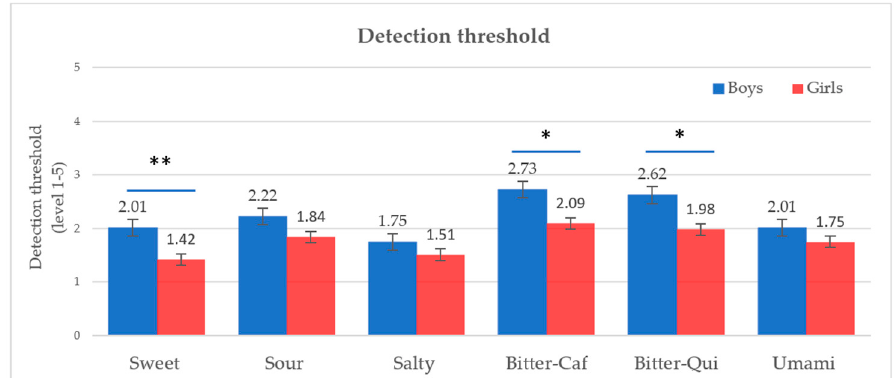
Figure 2. Detection threshold according to gender (* p < 0.1, ** p < 0.05, t -test).